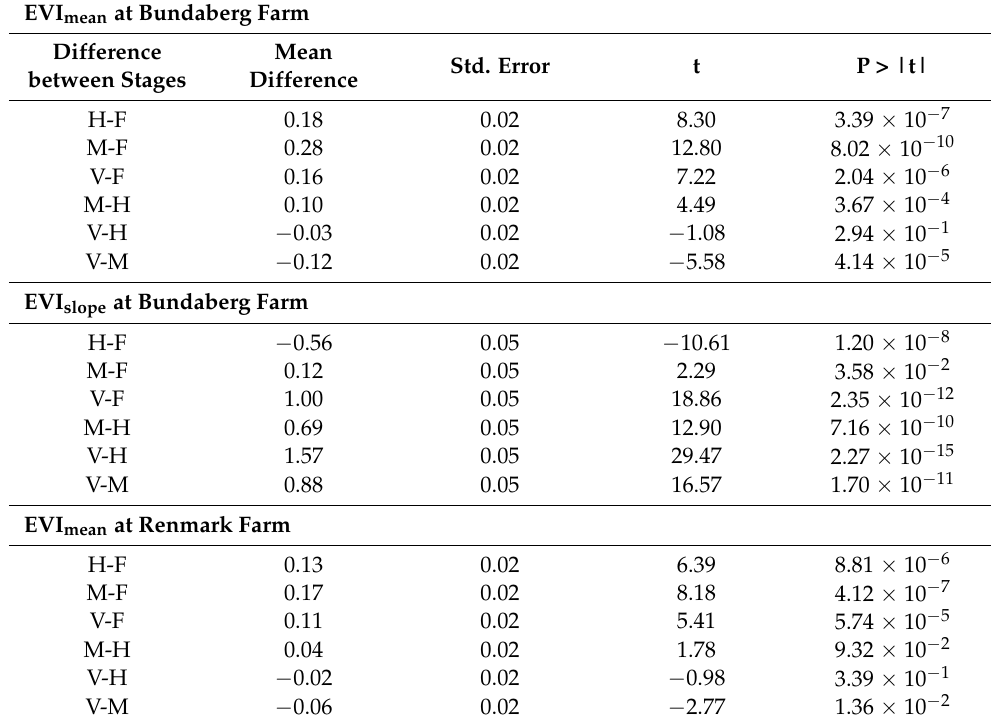
Table 2. Results of the Tukey-HSD test on the phenological stages for the Bundaberg and Ren- mark farms.